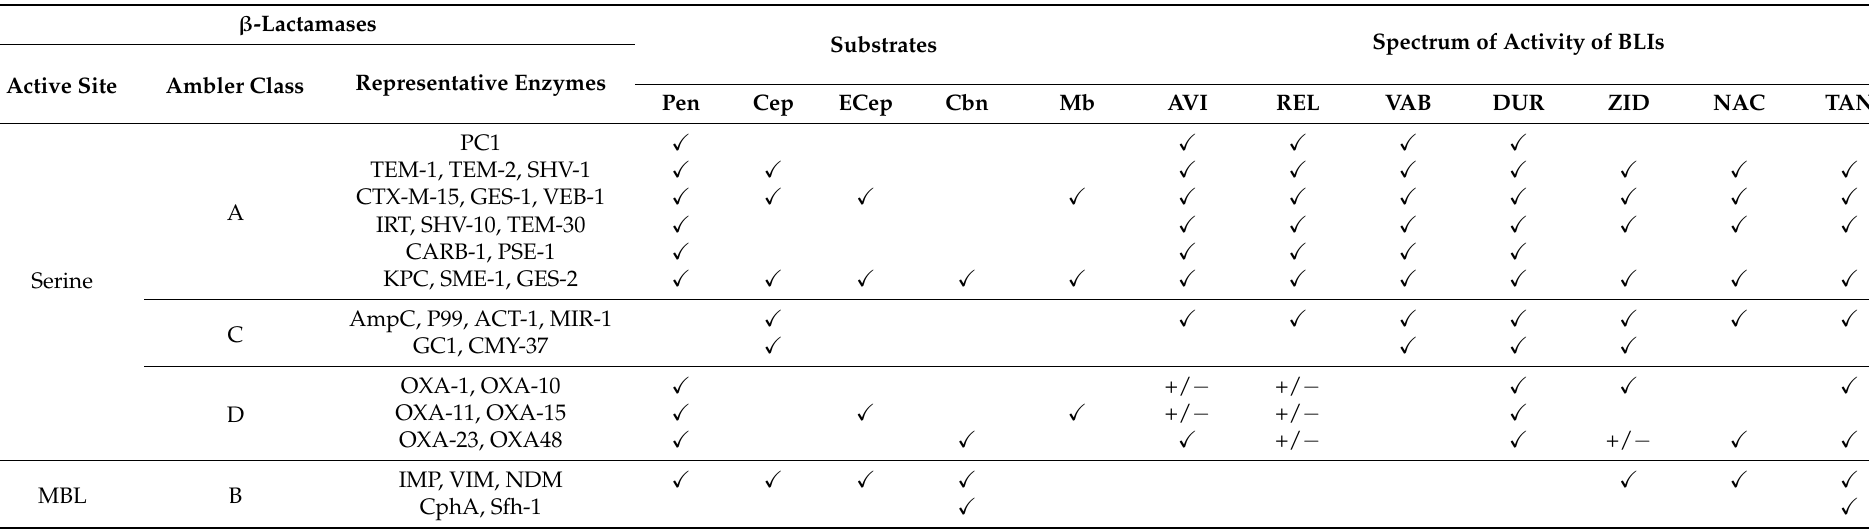
Table 1. Classification of BL and spectrum of activity of BLIs [2,17,22,24–29]. β -Lactamases